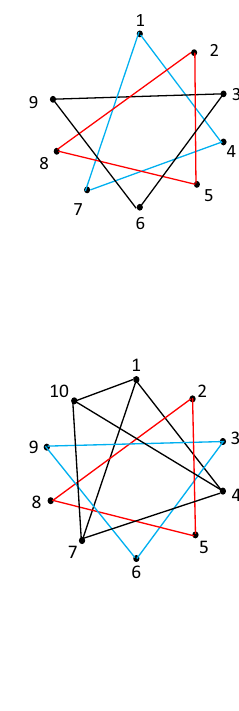
Fig. 3 Case n = 10 ; m =